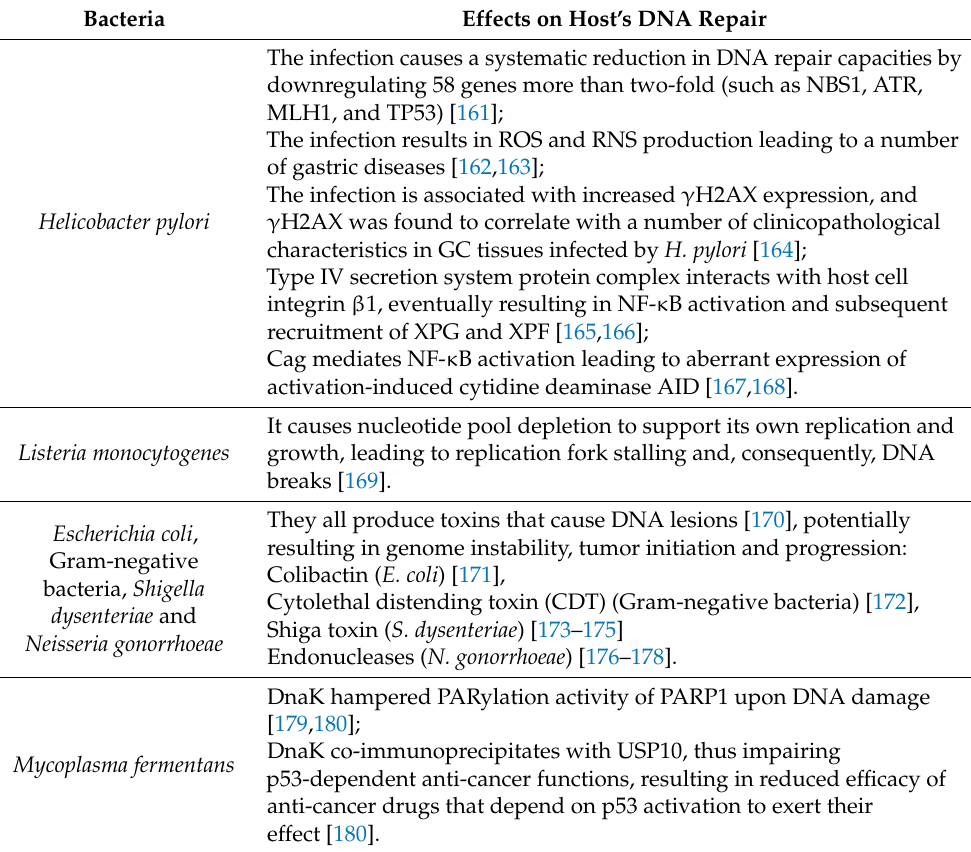
Table 2. Bacteria and DNA